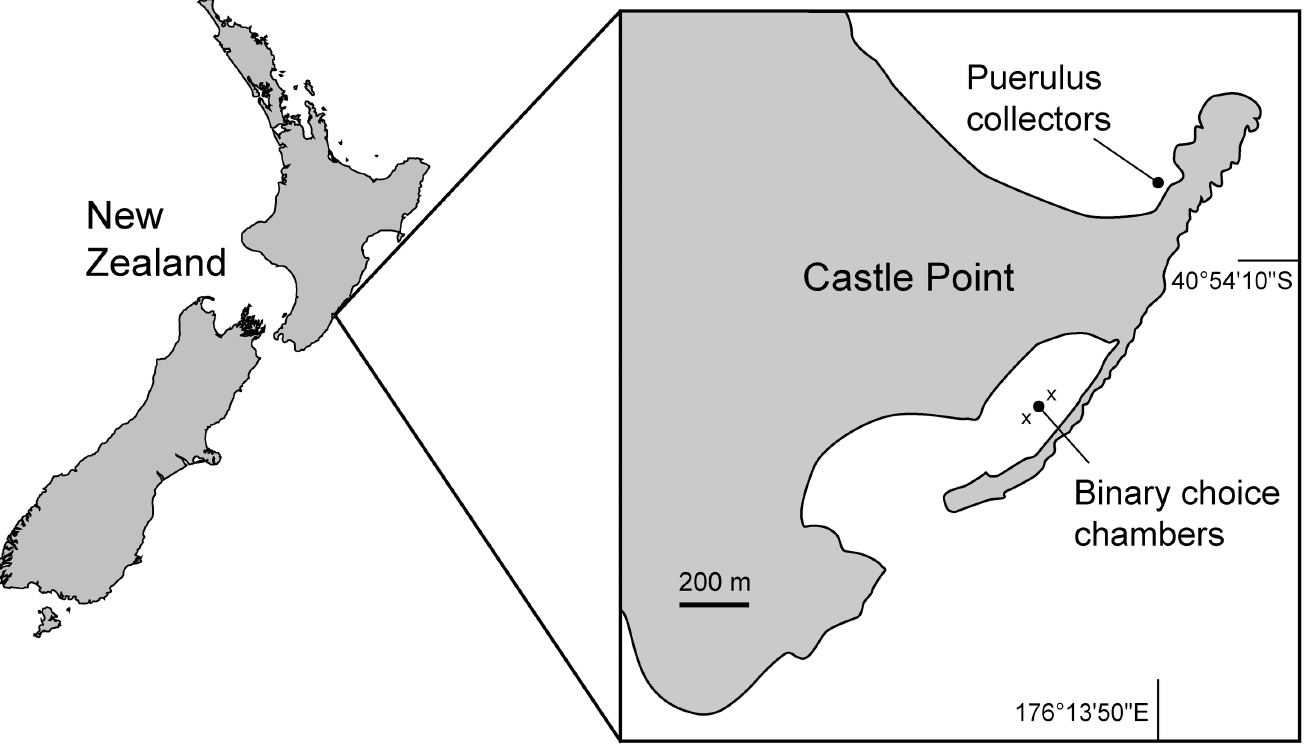
Fig 1. Map of the experimental site. Castle Point experimental sites used for collection of Jasus edwardsii pueruli and experimentation with behavioural choice chambers. “ X ” = positions of underwater speakers. The coastline was extracted from https://www.ngdc.noaa.gov/mgg/shorelines/ and